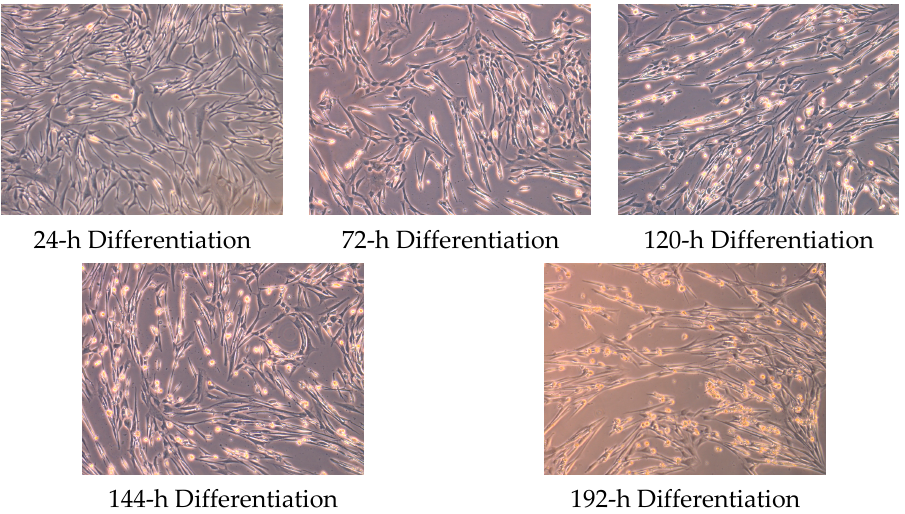
Figure 5. Skeletal muscle cells at various stages of differentiation.